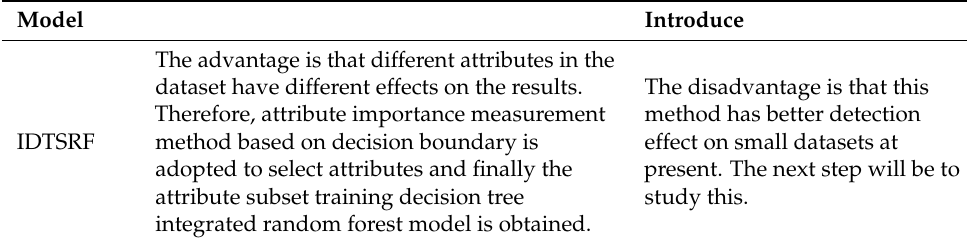
Table 1. Advantages and disadvantages of the